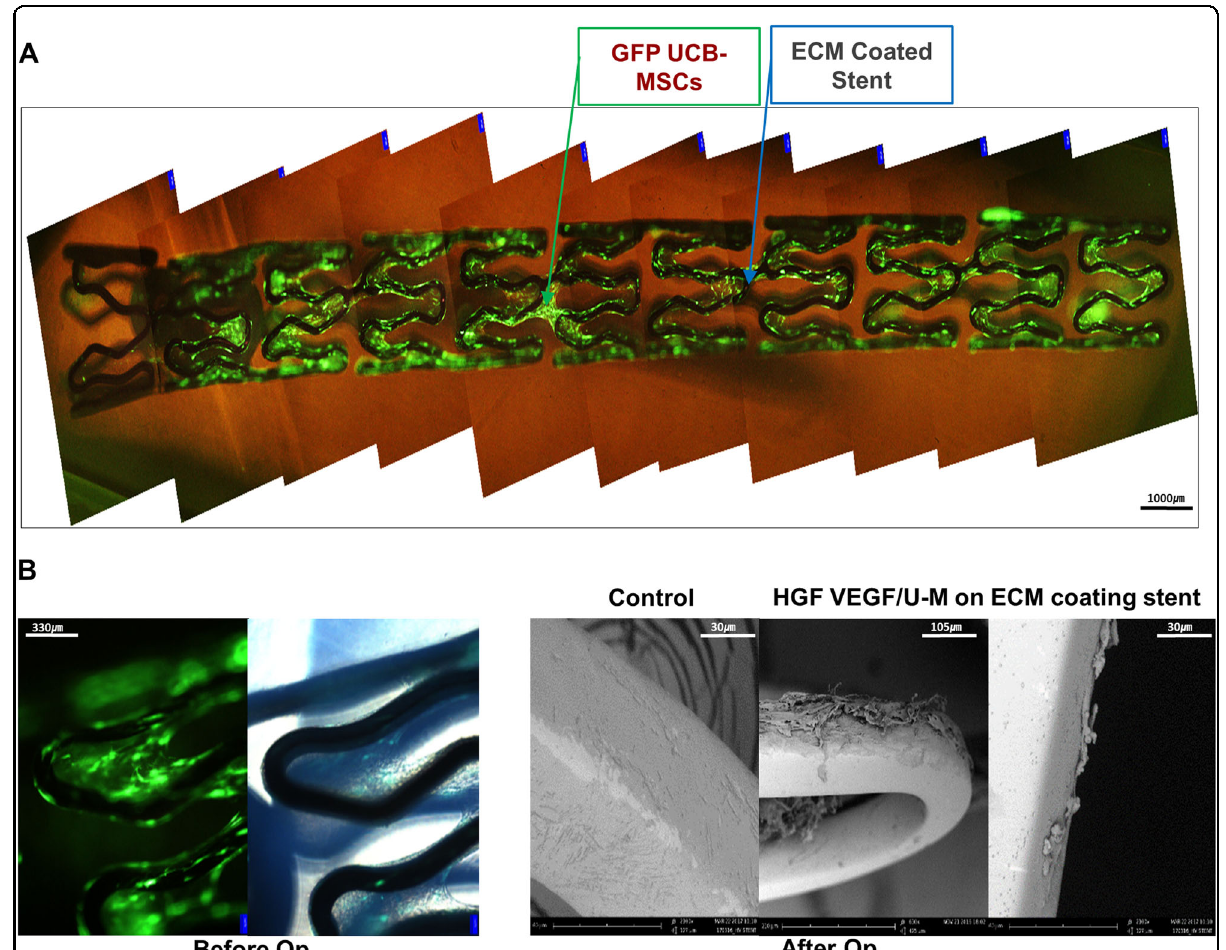
Fig. 2 The cells remained on the stent after transplantation. a Fluorescent images showing adhesion of the GFP-expressing UCB-MSCs on the stents. b Fluorescent images prior to surgery and stent seeding in the swine model were captured using a microscope, and the SEM images after the end of the experiment were captured using scanning electron microscopy. N =